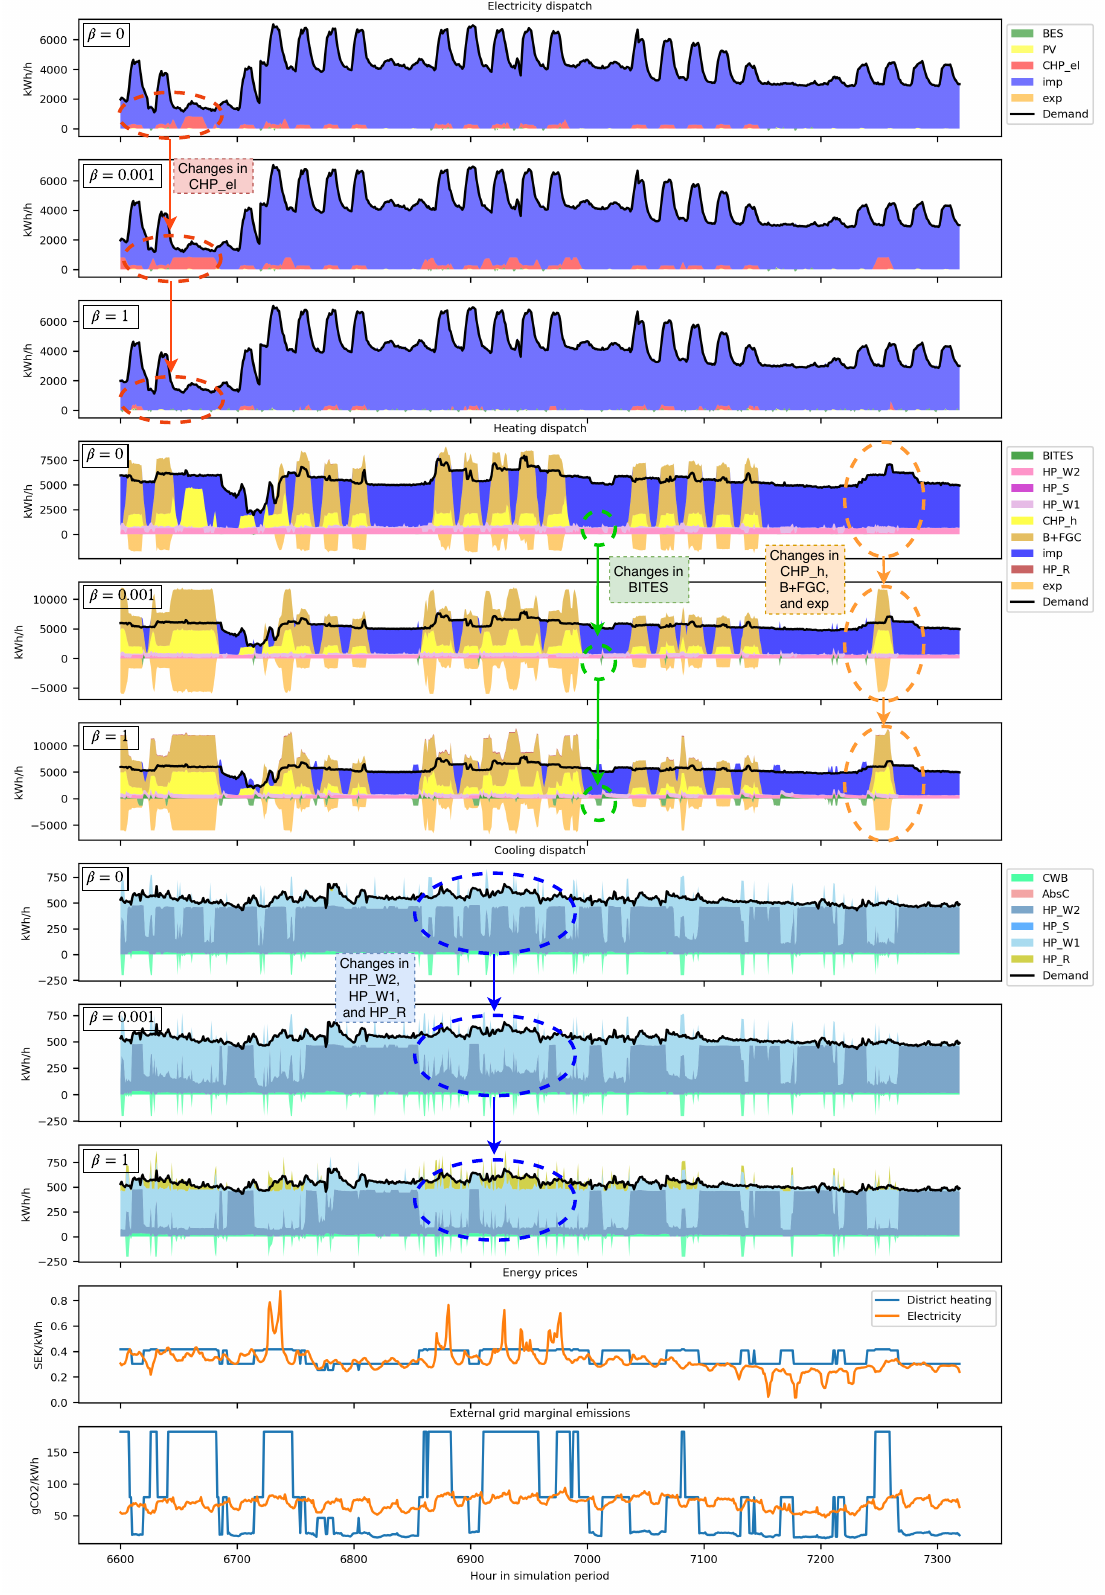
Figure 8. Dispatch time series for December 2016 for three β values of 0, 0.001, and 1 demonstrate some of the abatement strategies. Negative values in the dispatch plots represents exporting or charging of the storage